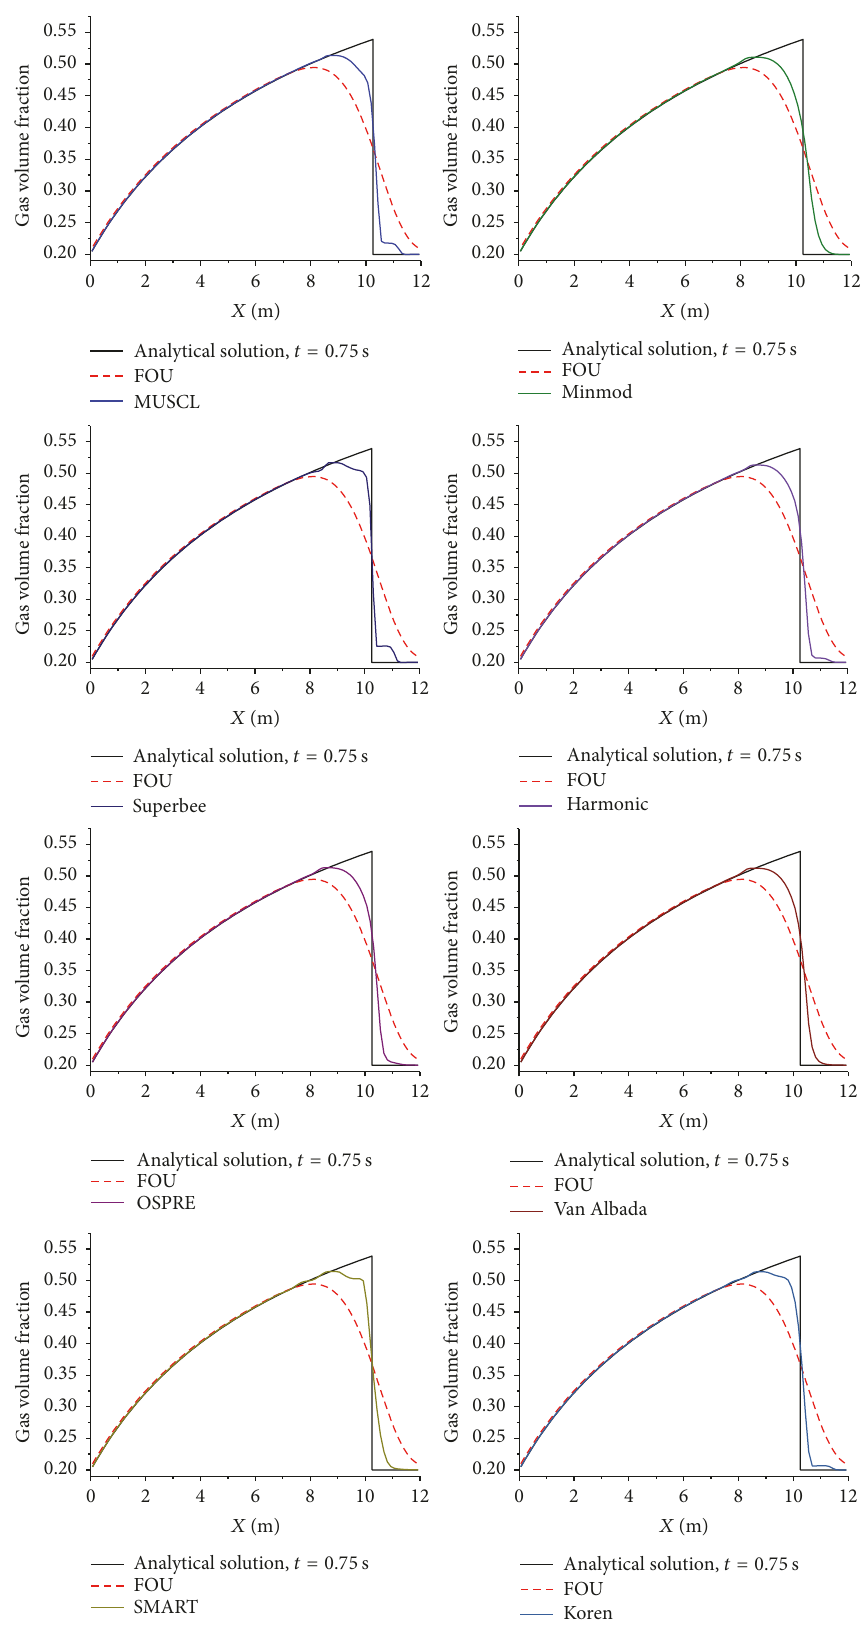
Figure 11: Numerical solutions of gas volume fraction for various high-resolution TVD schemes at time of 0.75